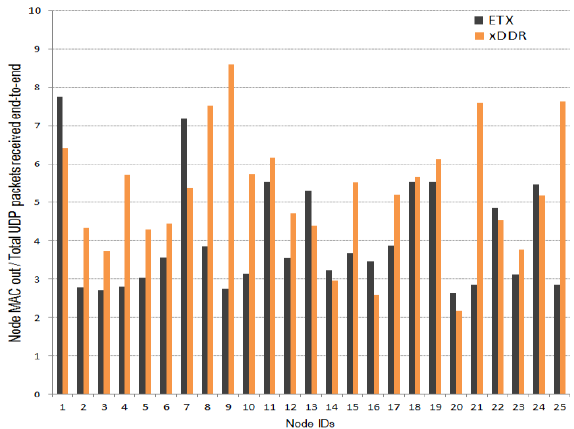
Figure 9: Ratio of packets transmitted by MAC layer of each node w.r.t. total UDP packets